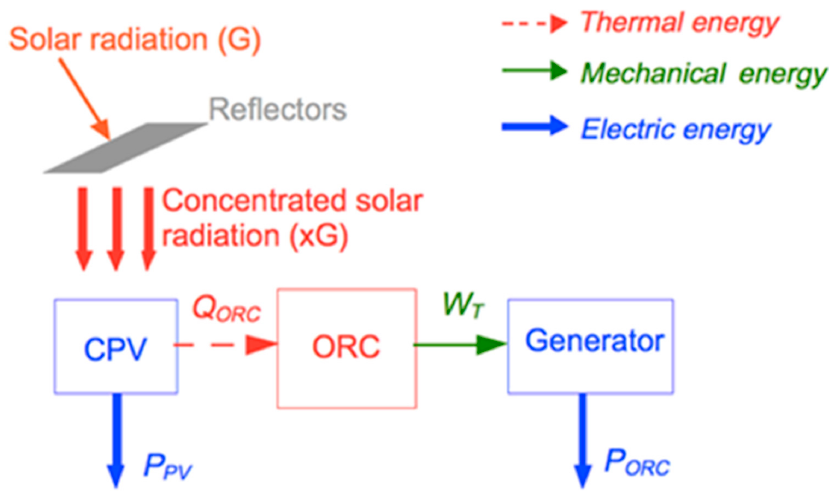
Figure 2. Scheme of the integrated CPV/T-oragnic rankine cycle (ORC) system.